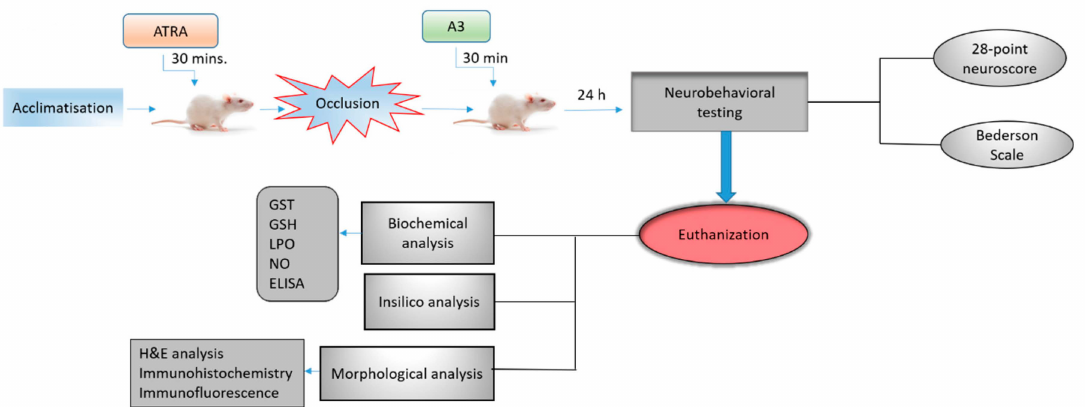
Figure 2. Schematic representation of the in vivo study design. Sham group: rats underwent surgery without filament insertion, vehicle-treated-p-MCAO group: rats treated with vehicle after p-MCAO induction, A3 + p-MCAO (5 mg / kg) group: rats received 5 mg / kg of A3, 30 min after p-MCAO, A3 + p-MCAO (10 mg / kg) group: rats received 10 mg / kg of A3, 30 min after p-MCAO, ATRA + p-MCAO (5 mg / kg) group: rats received 5 mg / kg of All trans-retinoic acid (ATRA) 30 min before